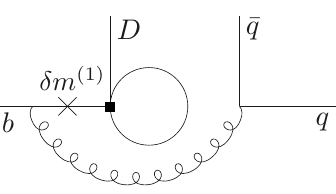
Figure 7 . Non-vanishing tadpole contribution to ( (cid:0) i ) (cid:14)m (1) e A 0 (1)nf